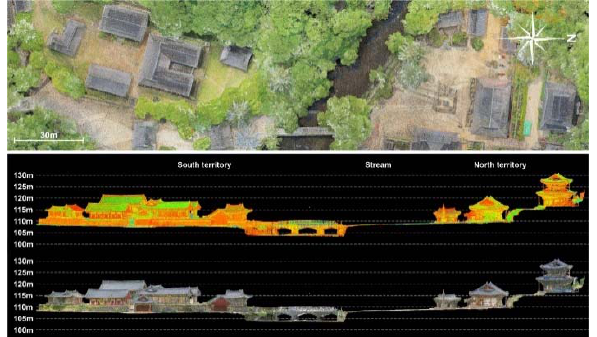
Figure 9. Cross section of the terrain of the Magoksa